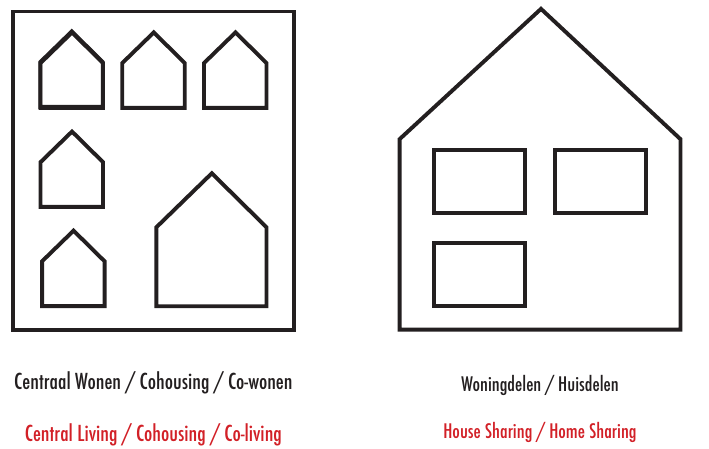
Figure 1. CH schemes adapted from Samenhuizen